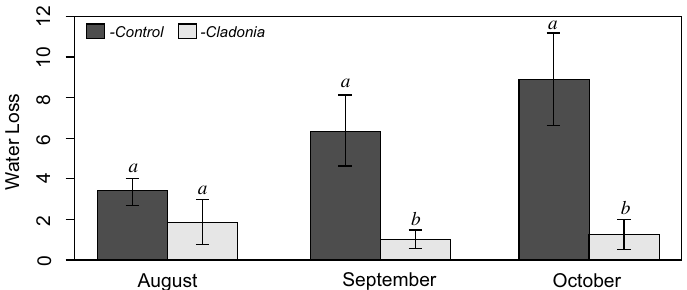
Supplementary Figure 2. Substrate water loss for the two control modules and eight Cladonia modules during the 2012 growing season.